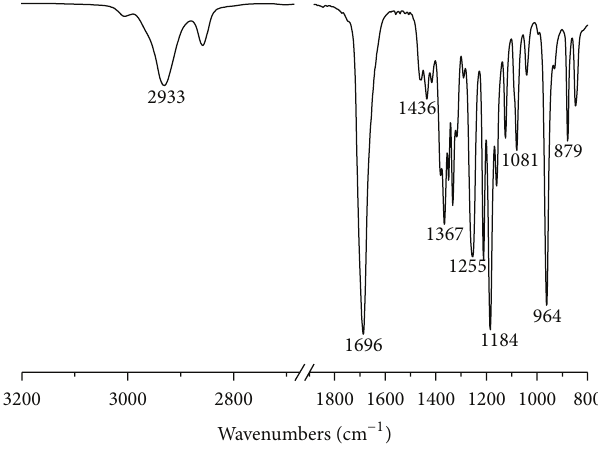
Figure 1: FT-IR spectrum of N-acetylcaprolactam.